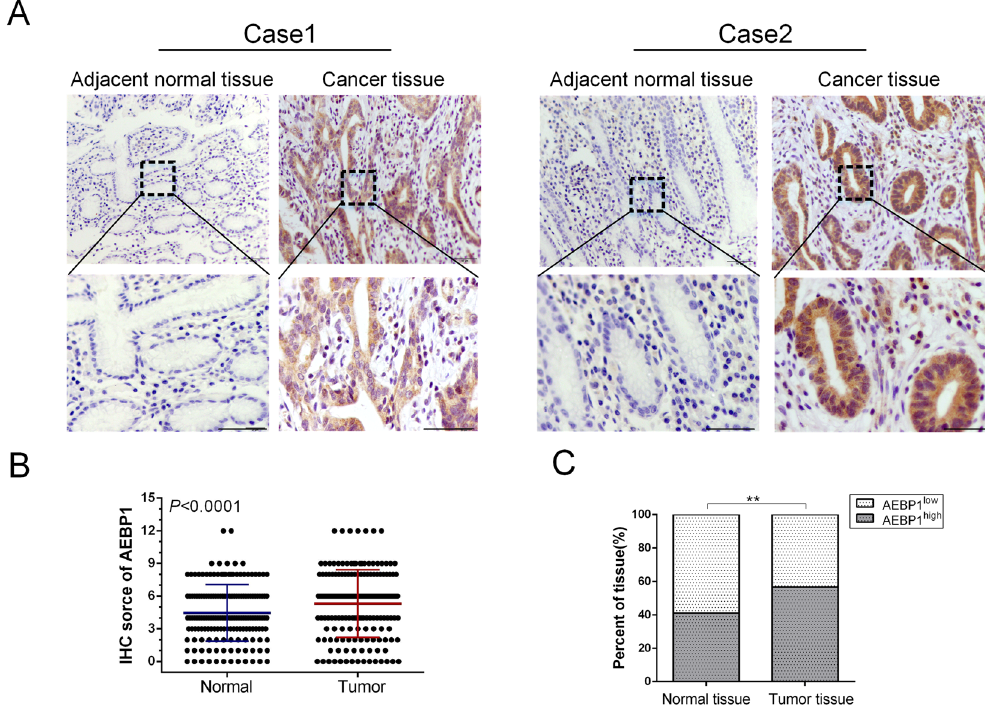
Figure 1. AEBP1 is highly expressed in gastric cancer tissues. ( A ) Representative immunohistochemical staining of AEBP1 in adjacent normal mucosa and gastric cancer tissue. Bar, 50 μ m. ( B ) The immunohistochemical score of AEBP1 was significantly higher in gastric cancer tissues than in adjacent normal tissues. ( C ) High expression of AEBP1 was more frequent in gastric cancer tissues than in adjacent normal tissues; ** P <